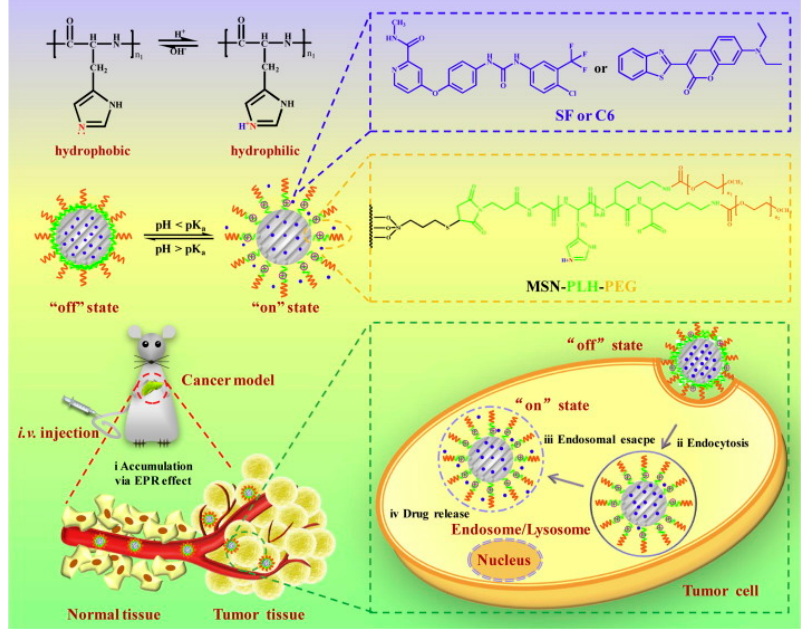
Figure 7. Schematic presentation of pH responsive drug release with the aid of poly(L-histidine) (PLH) coated MSNs. Reproduced with permission from reference [31]. coated MSNs. Reproduced with permission from reference